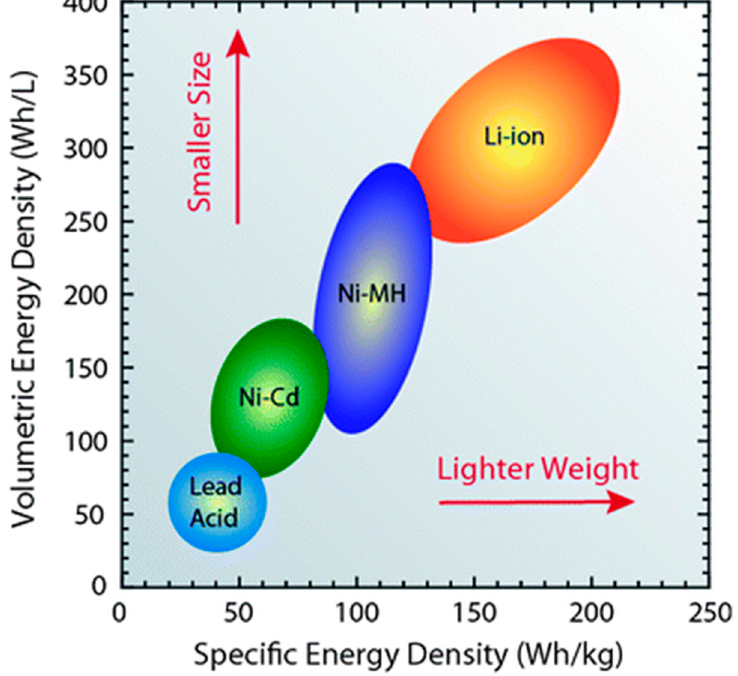
Figure 9. Graphical comparison of di ff erent rechargeable battery technologies in terms of their volumetric and specific energy densities. The arrows indicate the direction of development to reduce battery size and weight [111].